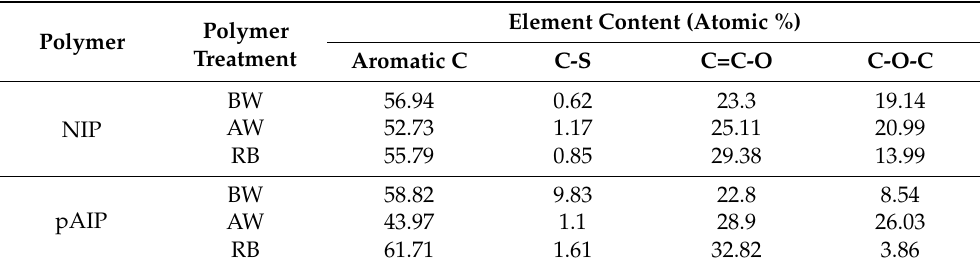
Table 2. Results of XPS elemental analyses of the PA-templated poly(TPARA- co -EDOT) using decon- voluted C 1s